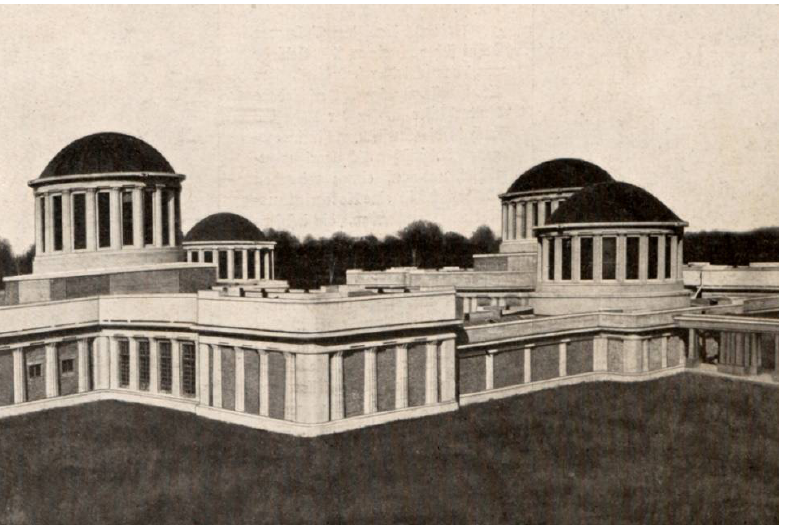
Figure 5. Pavilion of the Four Domes, built in 1912–1913 and designed by Hans Poelzig, Breslau Exhibition Grounds (Buchwald 1913, p. 17).